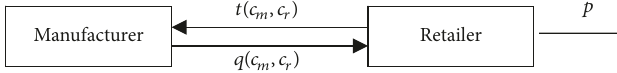
Figure 1: Supply chain structure.